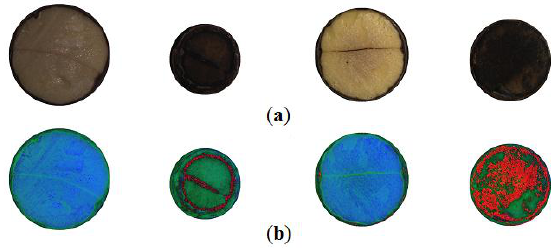
Figure 2. Selected segmented cross-section, Id. (from the left): 197, 200, 201, 206: ( a ) images captured by machine vision camera; ( b ) preview of HSV components rendered into RGB format.